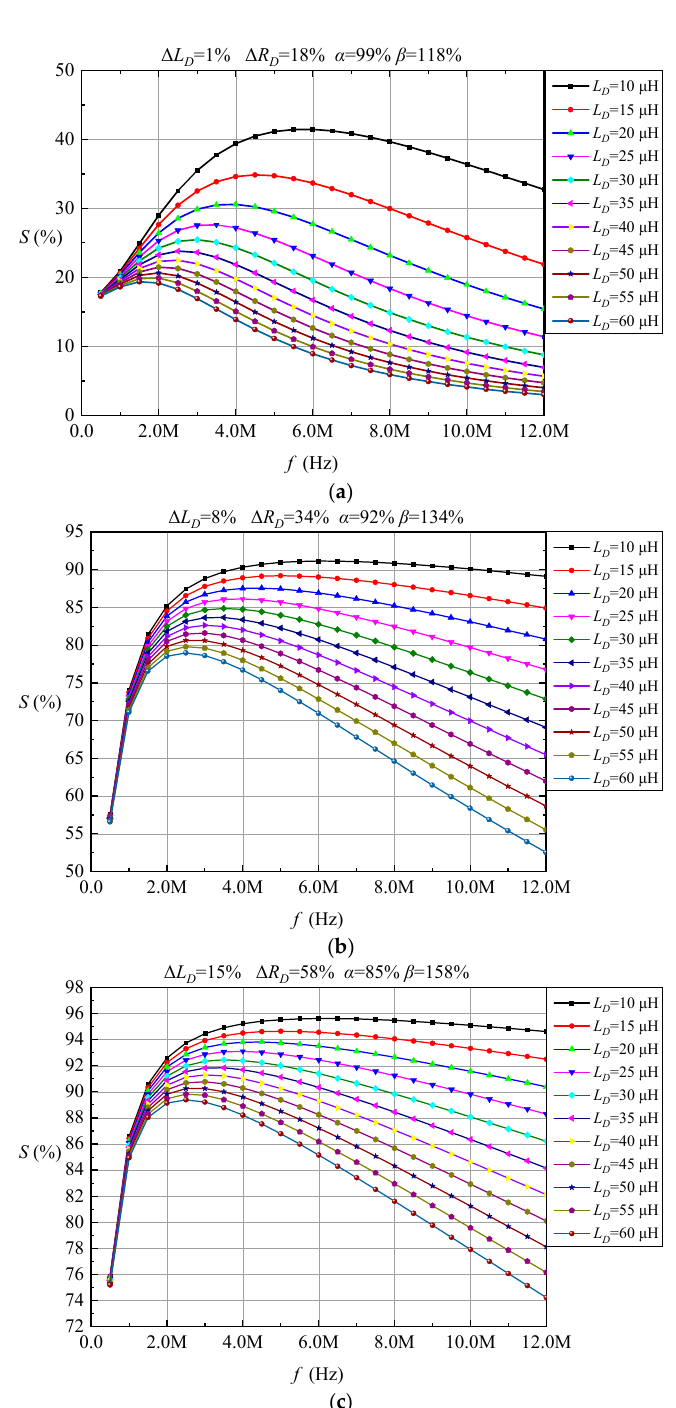
Figure 5. The relationship between the detection sensitivity of different self-inductance value detec- tion coil and the excitation source frequency f with different proportional impedance changes: ( a ) Δ L D = 1%, Δ R D = 18%, α = 99%, β = 118%; ( b ) Δ L D = 8%, Δ R D = 34%, α = 92%, β = 134%; ( c ) Δ L D = 15%, Δ R D = 58%, α = 85%, β = 158%.